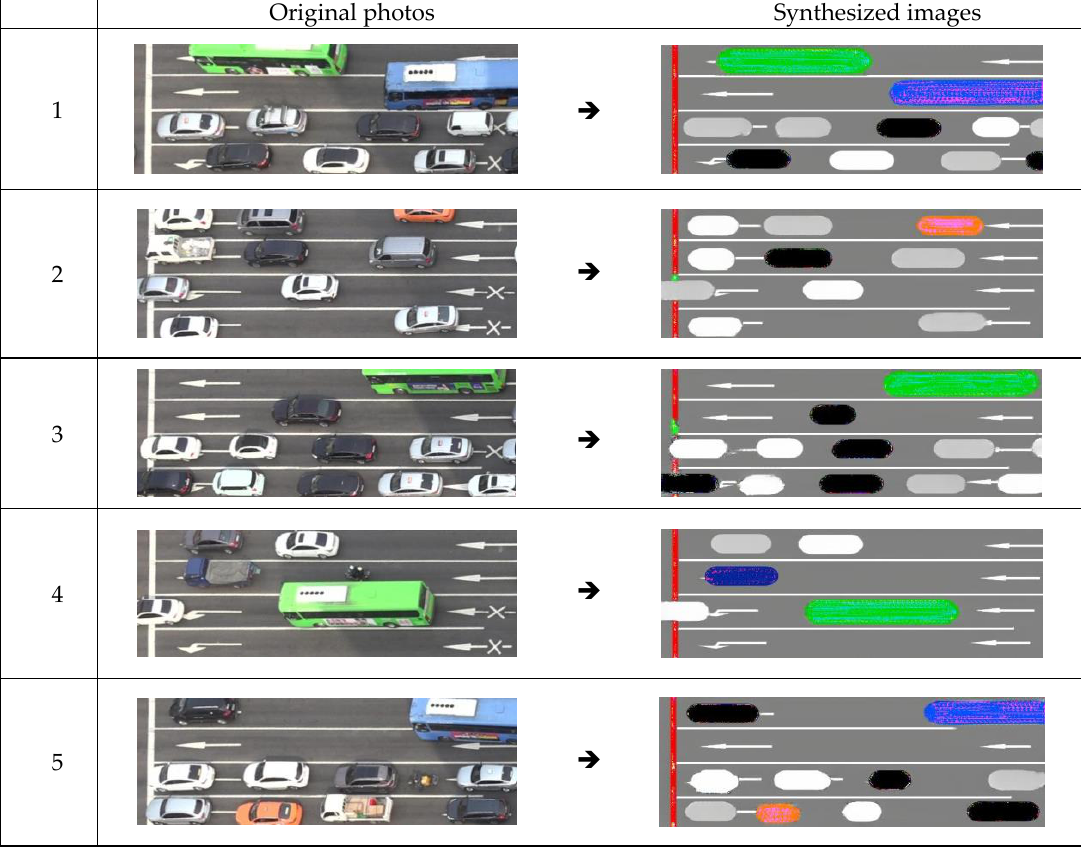
Table 3. The precision and recall of the autoencoder when synthesized images are used as input.